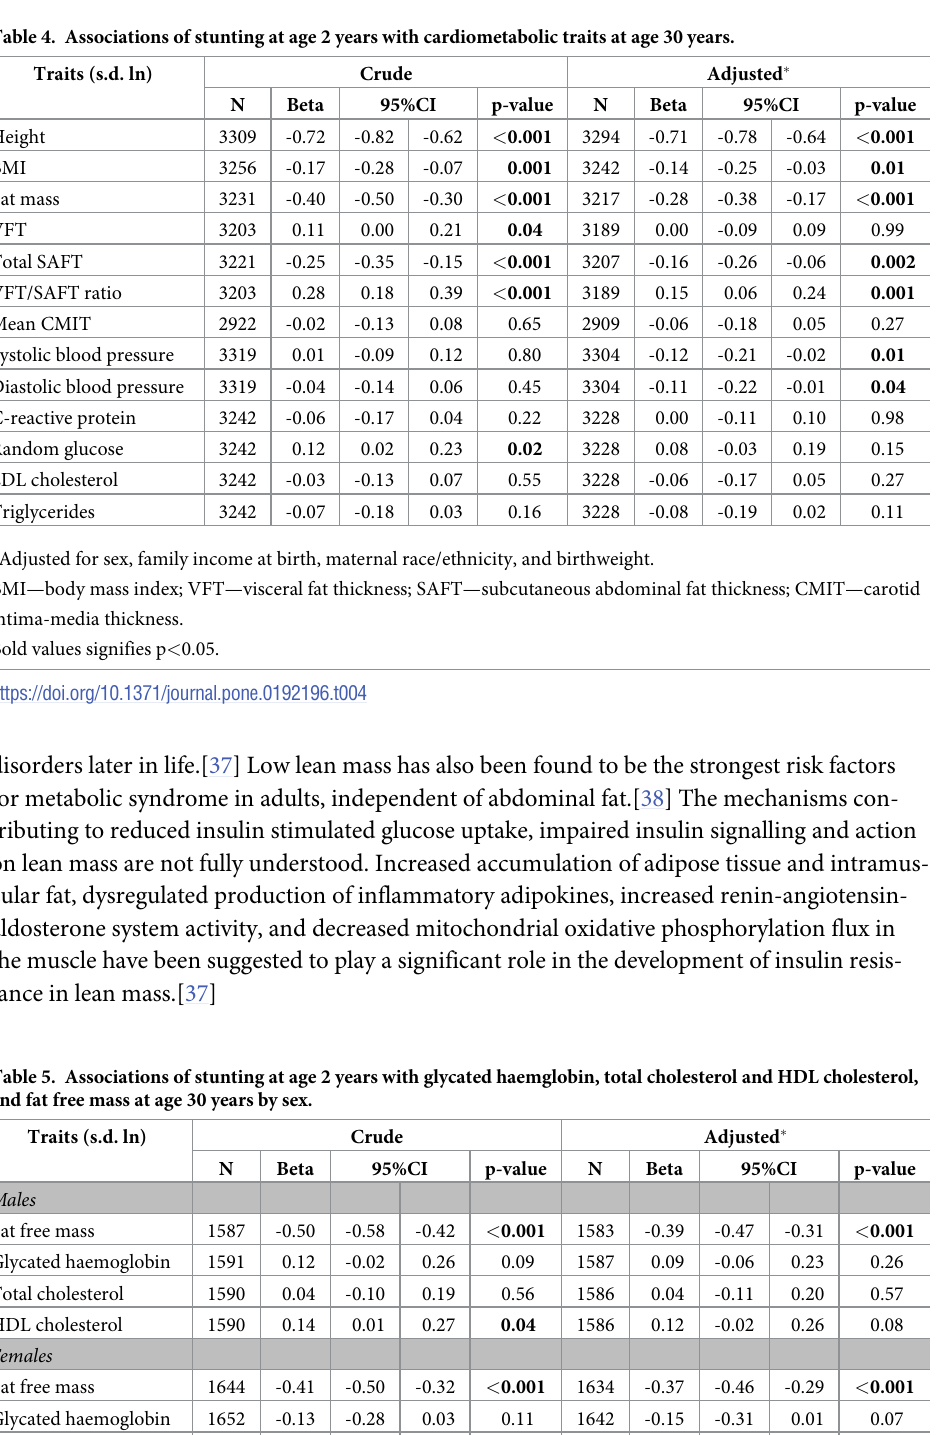
(cid:3) Adjusted for family income at birth, maternal race/ethnicity, and birthweight. Bold values signifies p < 0.05.